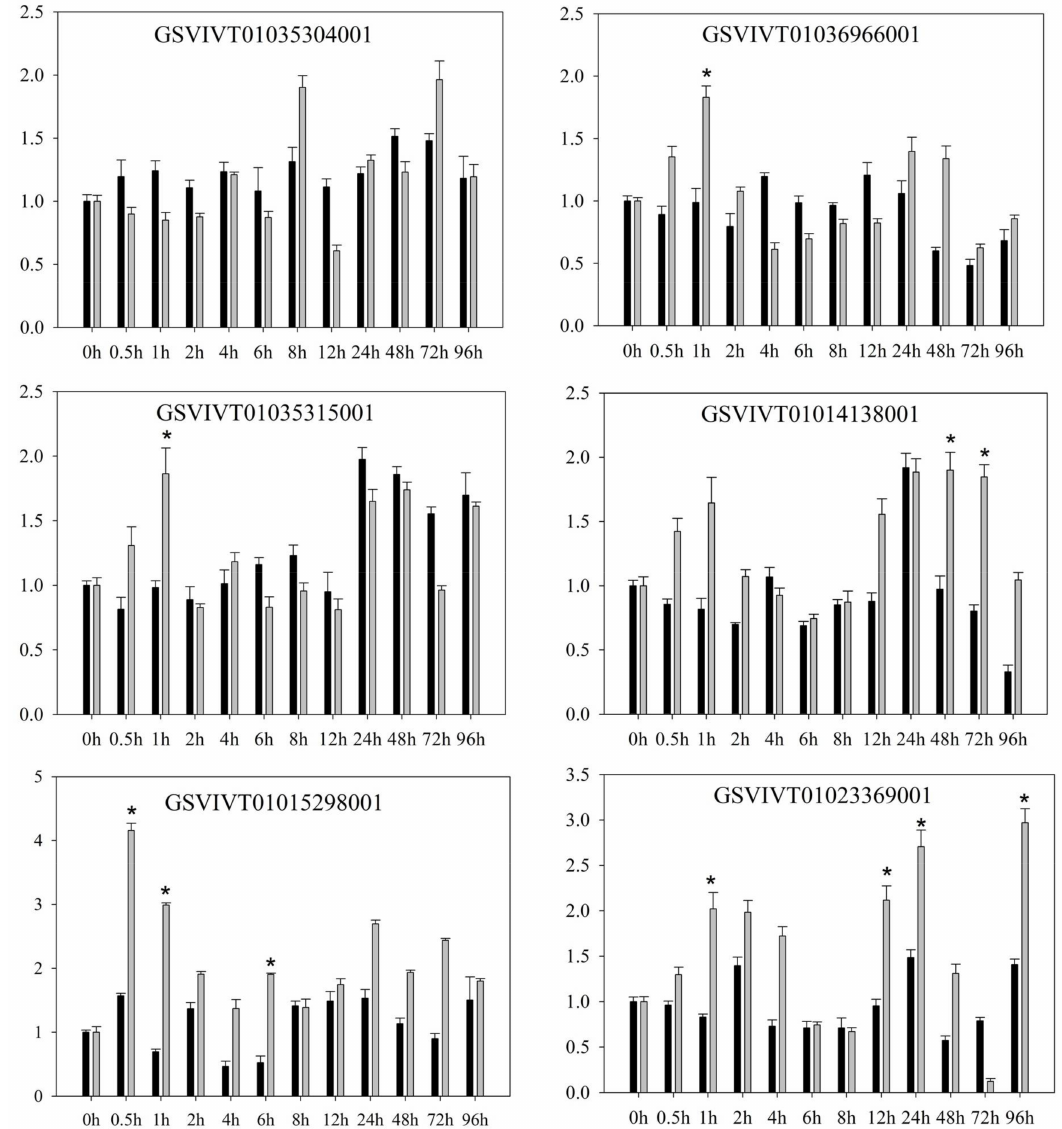
Figure 2. Relative expression of the PRR genes of Vitis amurensis ‘Shuanghong’ after inoculation with Plasmopara viticola “ZJ-1-1” (black bars) and P. viticola “JL-7-2” (gray bars). Values on the vertical axes indicate the fold-change in gene expression, normalized to the expression level of Vitis EF1- α , SAND, and UBQ. The x -axes represent the time since inoculation. Error bars represent the standard deviation calculated from three replicates. * indicates significant differences ( p < 0.05) as determined with Student’s t -test. Significant differences were identified by comparing the two gene expression levels at each time